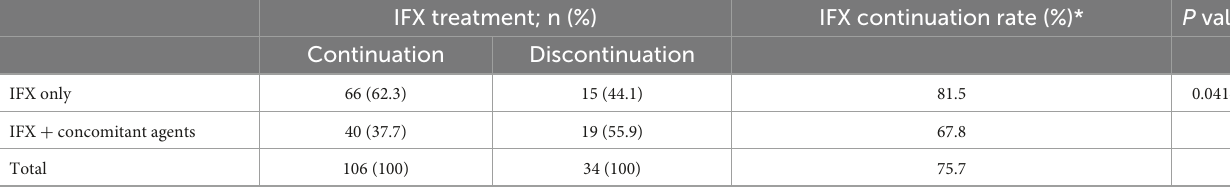
TABLE 1 Concomitant agents and 10-year infliximab continuation